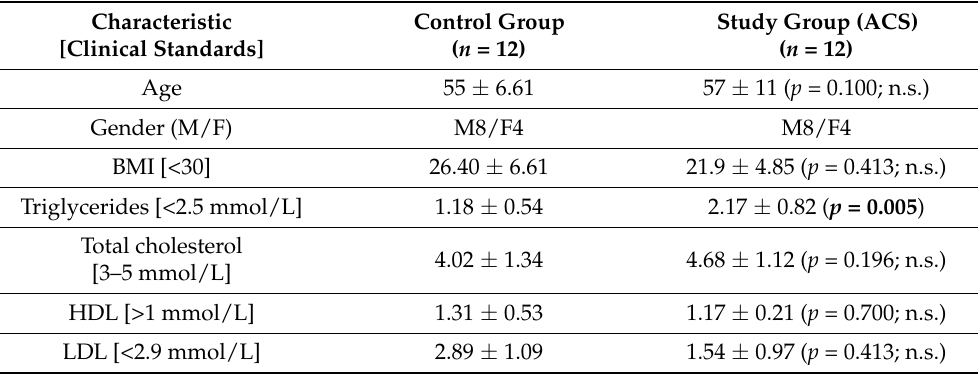
Table 4. Clinical characteristics of the ACS patients and control